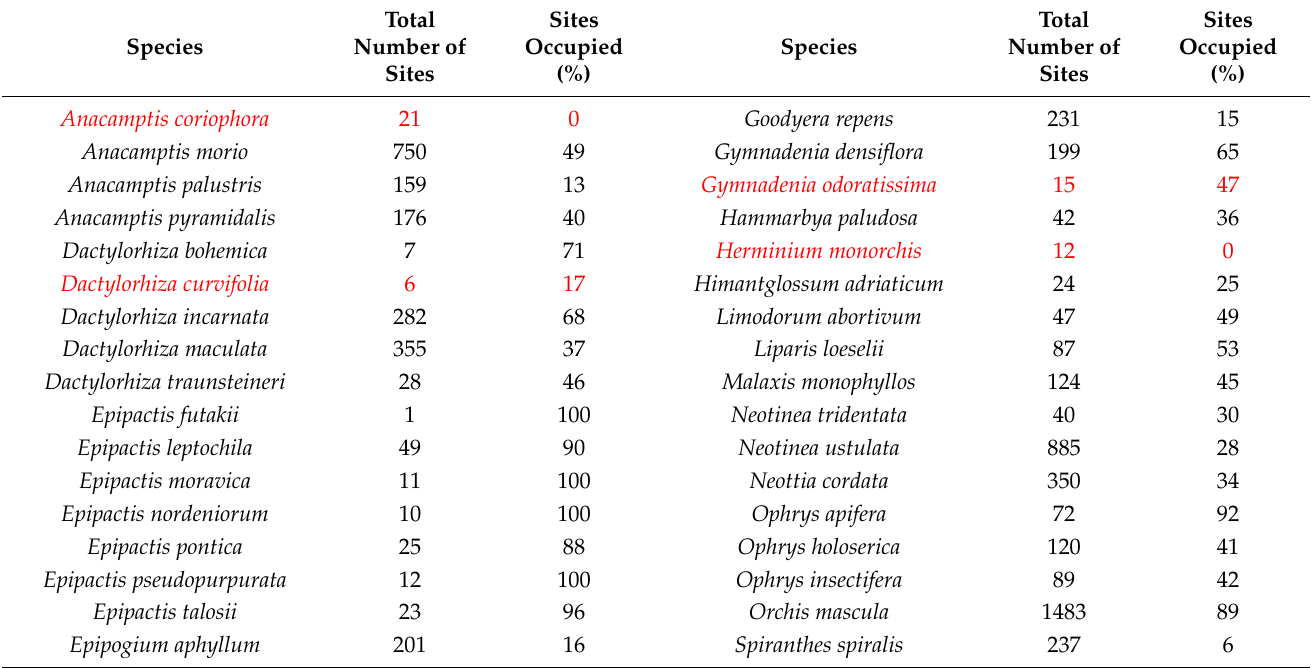
Table 2. The total number of sites and their proportion occupied at the last interval for each orchid species analyzed in the Czech Republic. Species in red are considered to be extinct (category A1 in the national Red Lists) in the Czech Republic in 2020 according to available literature